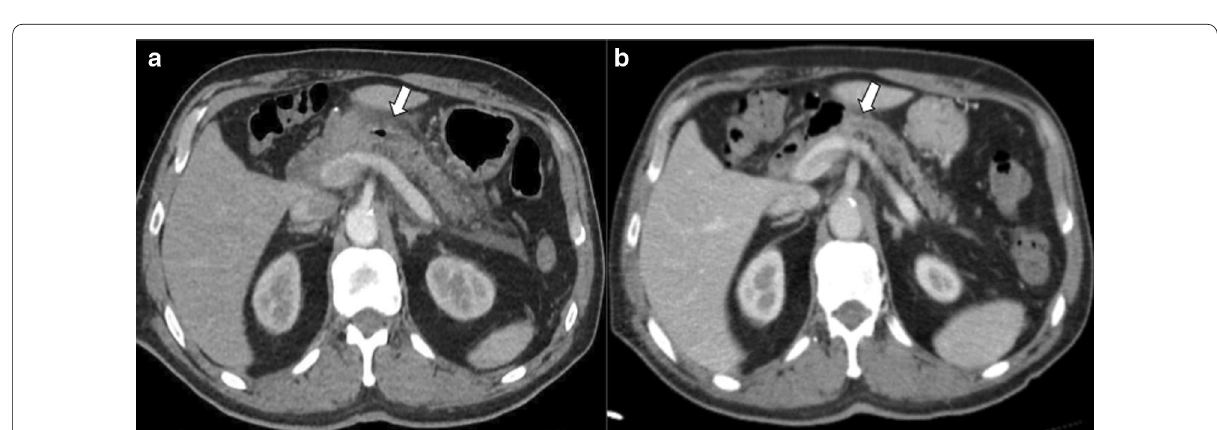
Fig. 18 Pancreatojejunostomy stenosis and recurrent pancreatitis ( a ) 72-year-old male patient with history of pancreaticoduodenectomy due to chronic pancreatitis in the setting of acute stump pancreatitis (big arrow). Endoscopic ultrasound revealed pancreaticojejunostomy with decreased caliber. ( b ) Control CT scan performed three months later denote normal wirsung